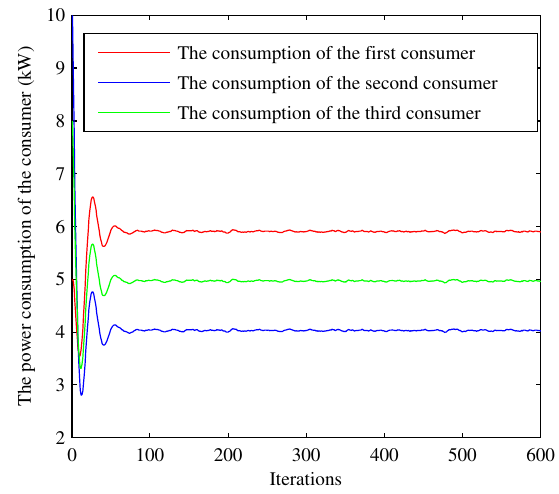
Figure 9. Convergence of the power consumption under case